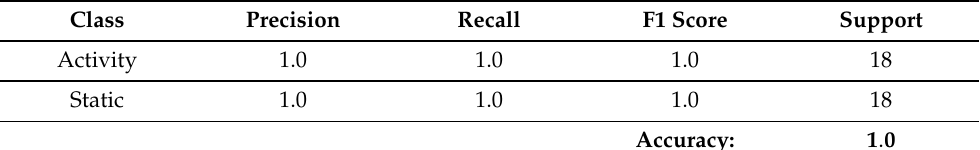
Table 2. Classification statistics for OAMD algorithm.